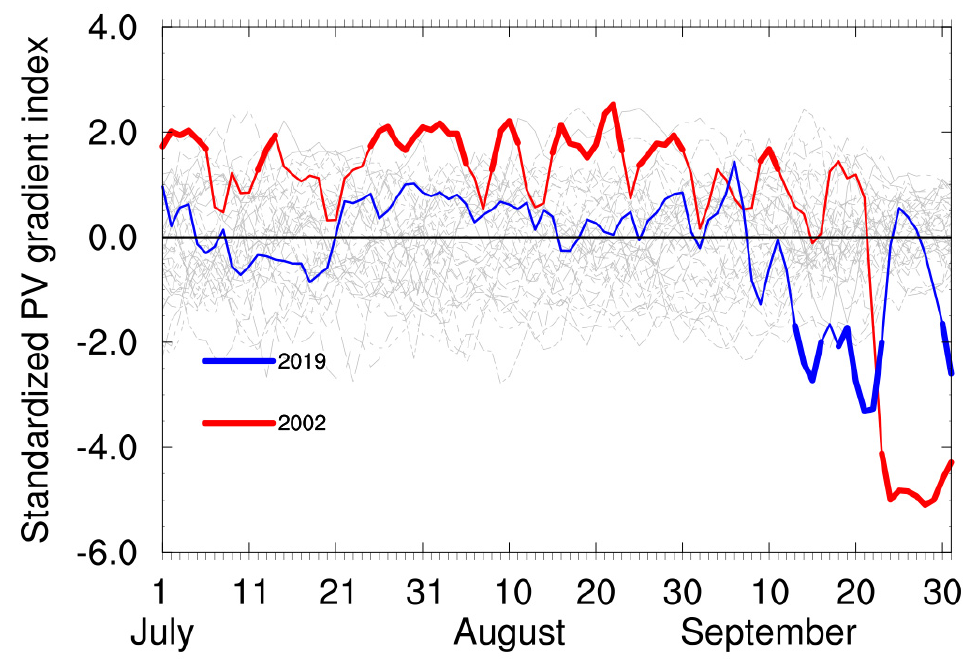
Figure 8. Time series of standardized meridional potential vorticity gradient index from 1 July to 30 September in 2002 (red), 2019 (blue), and other years (grey). Thick parts indicate that the value exceeds the 95th percentile over each calendar day from 1979 to 2019. Red and blue vertical lines denote the onset date of the 2002 and 2019 Antarctic SSW, respectively.